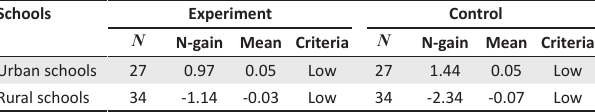
TABLE 1: N-gain score criteria. N-gain score Interpretation 0.70 < g High g < 0.30